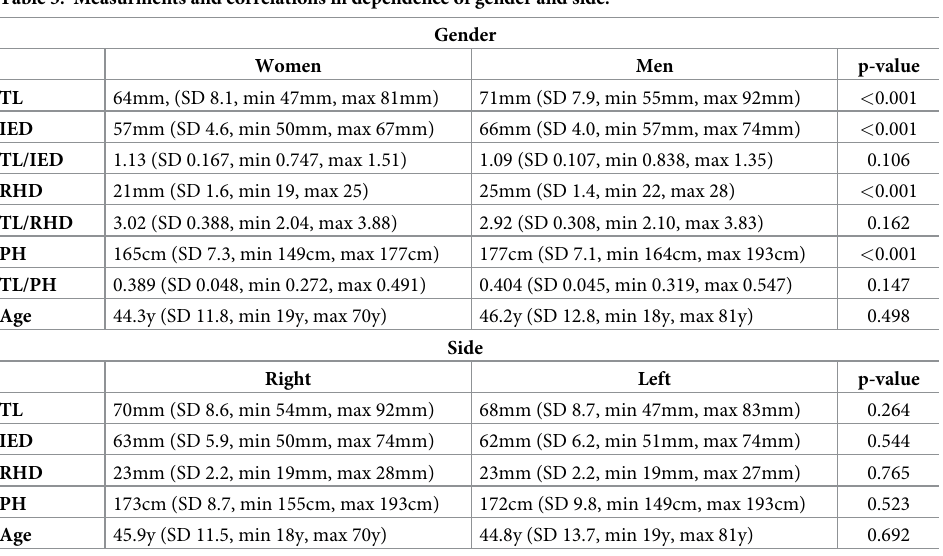
Table 3. Measurments and correlations in dependence of gender and